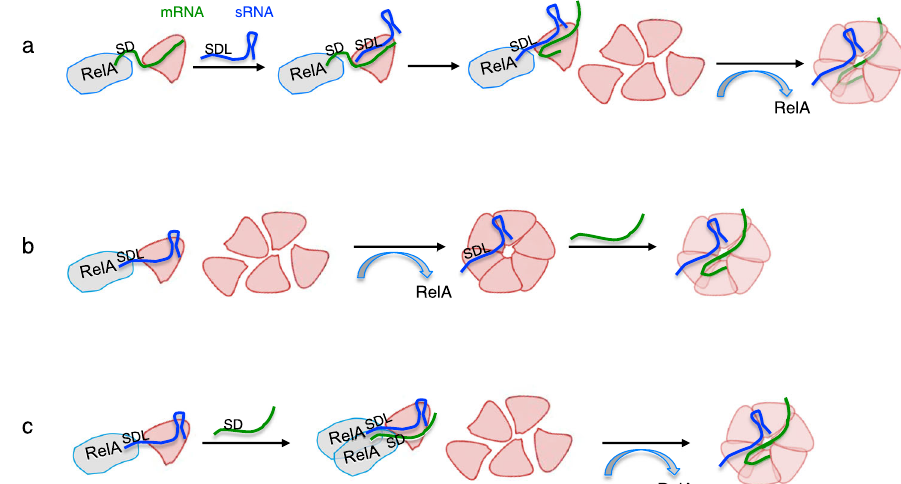
Fig. 7 RelA-mediated hexamerization of Hfq requires an initial binding of RNA to Hfq monomer. sRNA (blue); mRNA (green); Hfq subunits (pink). a RelA binds and stabilizes an unstable complex of mRNA-Hfq monomer leading to subsequent sRNA binding while RelA switches from SD of the mRNA to the GGAG site (SDL Shine – Dalgarno Like) in the sRNA promoting further stabilization of the complex and enabling Hfq hexamerization. b RelA stabilizes an unstable complex of sRNA-Hfq monomer by binding the GGAG (SDL) site in the sRNA leading to Hfq hexamerization followed by target mRNA binding. c RelA stabilizes an unstable complex of sRNA-Hfq monomer by binding the GGAG (SDL) site in the sRNA. The binding of SD site in the mRNA possibly by another RelA promotes further stabilization and ultimately Hfq hexamerization. In all cases, sRNA mediated mRNA regulation is expedited by RelA binding of